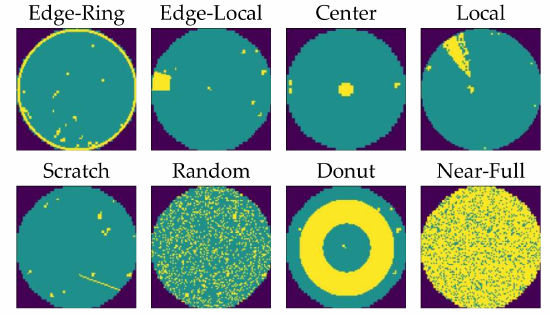
Figure 15. Augmentation based on generation.